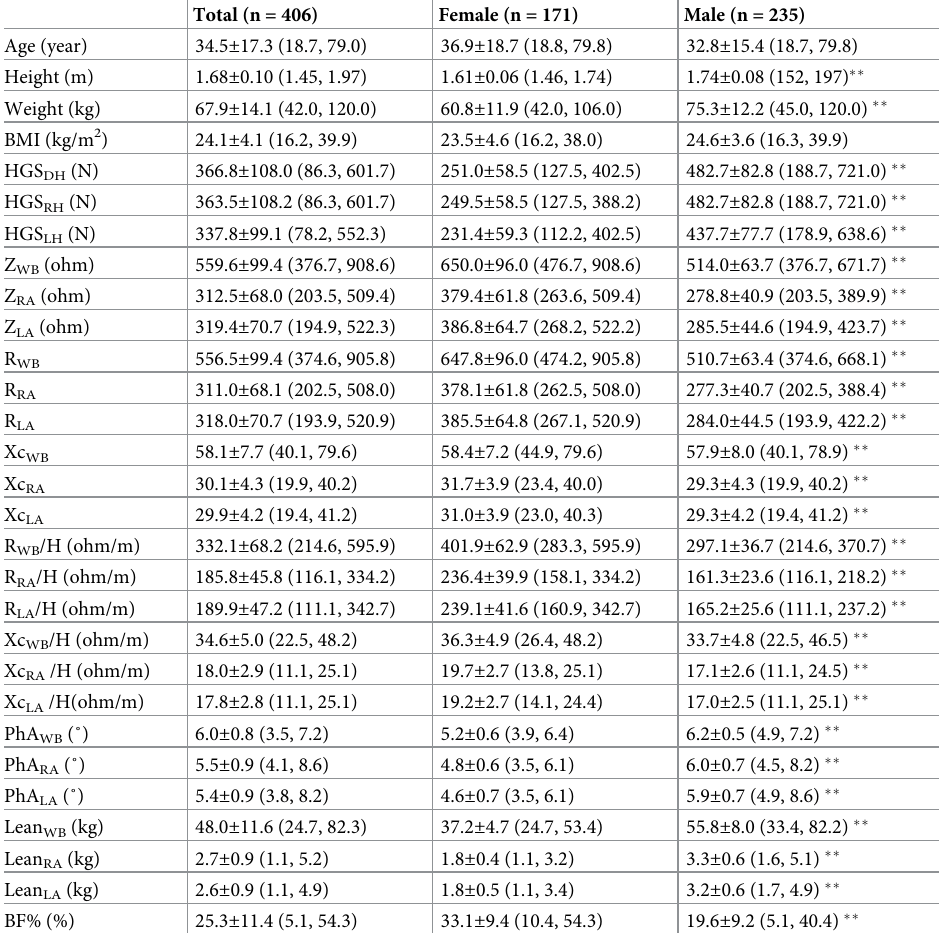
better than the correlations between whole body and left arm modes for all the BIVA variables. The results of the multiple regression analyses for HGS using basic indices and height- adjusted BIVA variables (R/H and Xc/H) as predictors are shown in Table 3. The variables were included in the stepwise regression analysis in the following order: sex, weight, age, height, Xc/H, and R/H. Model 1 was the regression model to predict HGS from basic indi- DH ces and whole-body mode BIVA parameters. Model 2 was the regression model to predict HGS based on basic indices and right hand mode BIVA parameters. Model 3 was the regres- RH sion model to predict HGS from basic indices and left hand mode BIVA parameters. LH